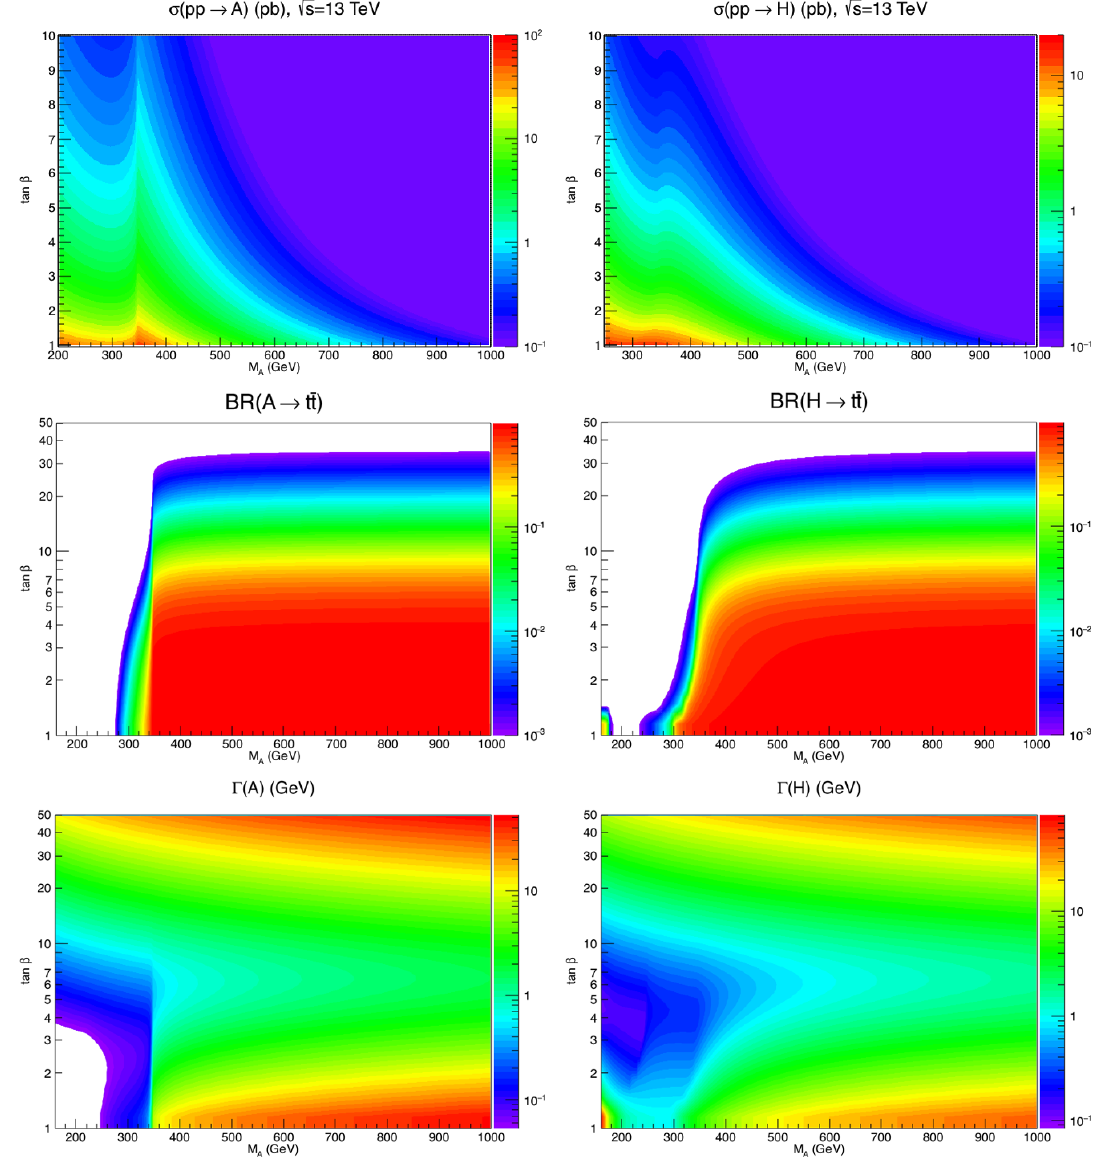
Figure 5 . The gg ! (cid:8) production cross sections at the 13 TeV LHC, the (cid:8) ! t (cid:22) t branching ratios and the total decay widths (cid:0) (cid:8) of the heavier MSSM Higgs bosons A (left) and H (right) in the [ M A ; tan (cid:12) ] plane, as predicted by the